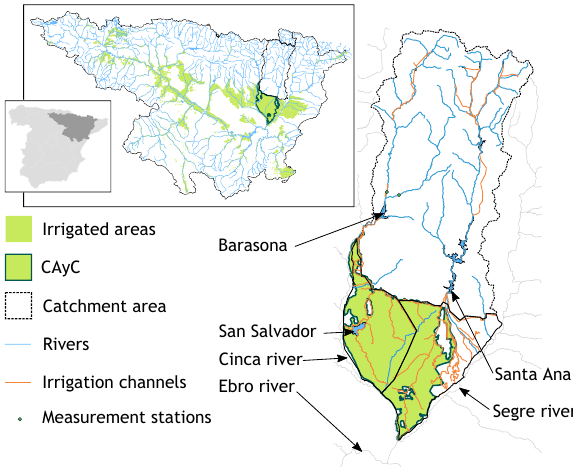
Figure 1. Canal de Aragón y Cataluña: irrigated area and catch- ment.